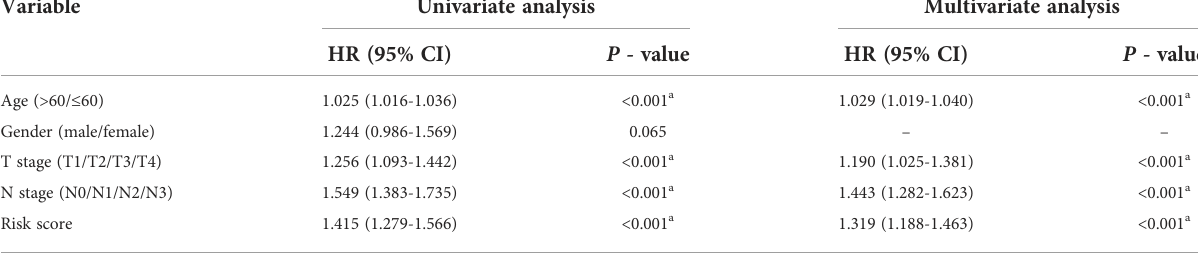
TABLE 1 Univariate and Multivariate Cox regression analyses of clinicopathologic characteristics associated with overall survival in the TCGA- GSE84437 cohort. Variable